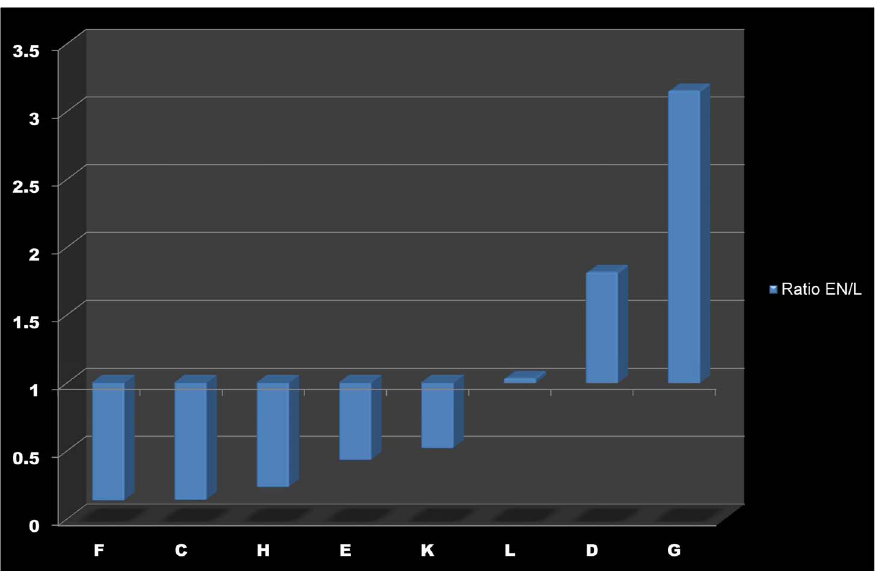
Figure 4. Relative changes of metabolic clusters under light and extended night conditions. Bars indicate the ratios of metabolic clusters from Col-0 under extended night and light conditions. Clusters are named according to the description in the main text ( Results) and Table S1.